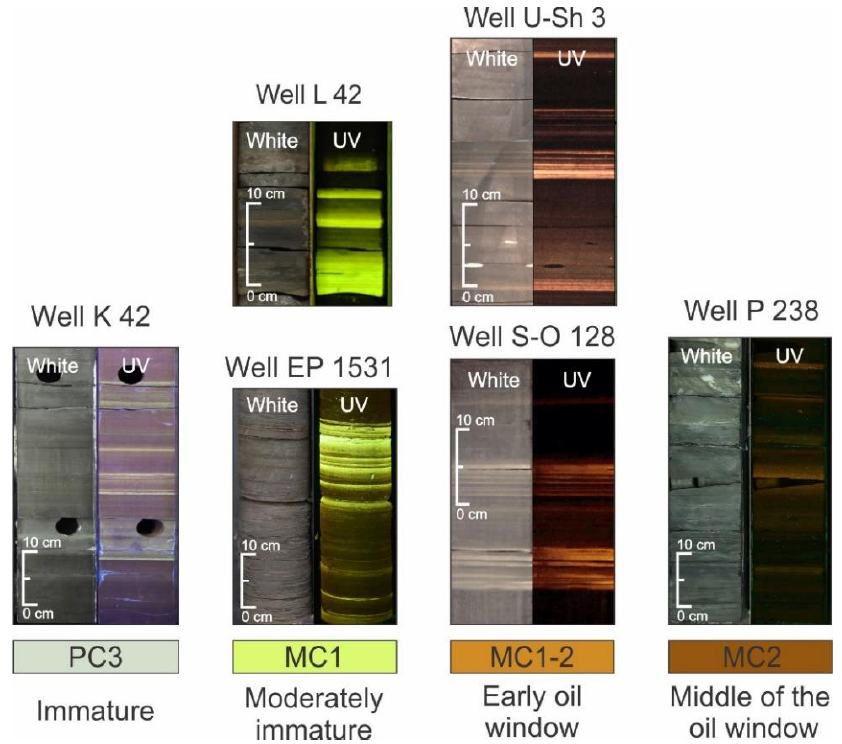
Figure 12. Color of the luminescent alginite-rich layers in the Bazhenov deposits of different thermal maturity.